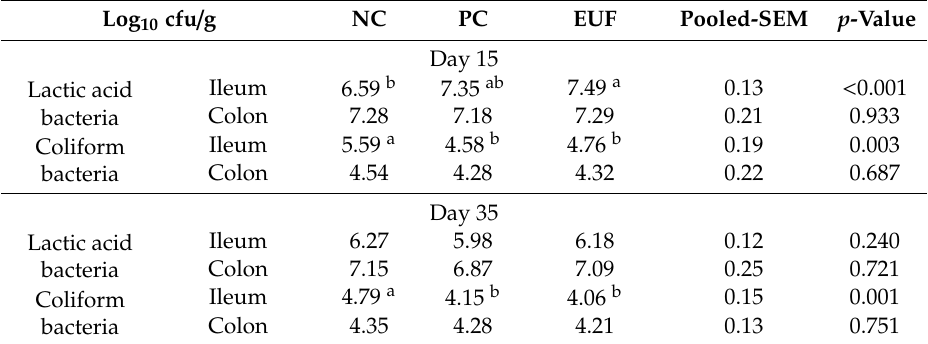
Table 3. Lactic acid bacteria and coliform bacteria in the ileum and colon of piglets 1,2 . Log 10 cfu / g NC PC